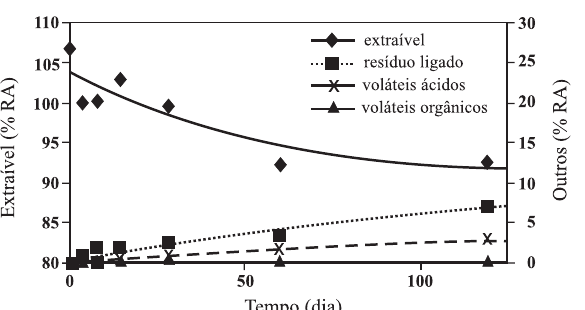
Figura 2. Quantificação de ametrina e seus metabólitos no extrato do solo lvdf como função do tempo de